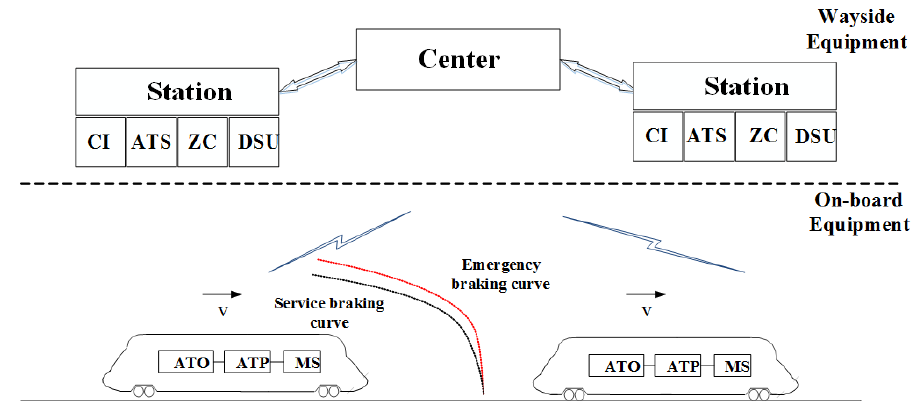
Figure 1. A typical communication-based train controls (CBTC)